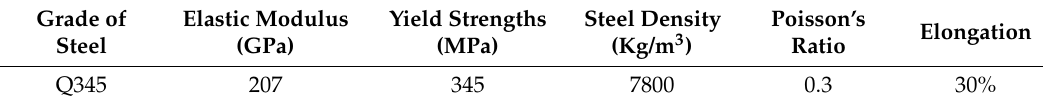
Figure 5. The codes of bar elements in triangle-on-triangle offset grid model. Table 1. Material characteristics of experimental model.